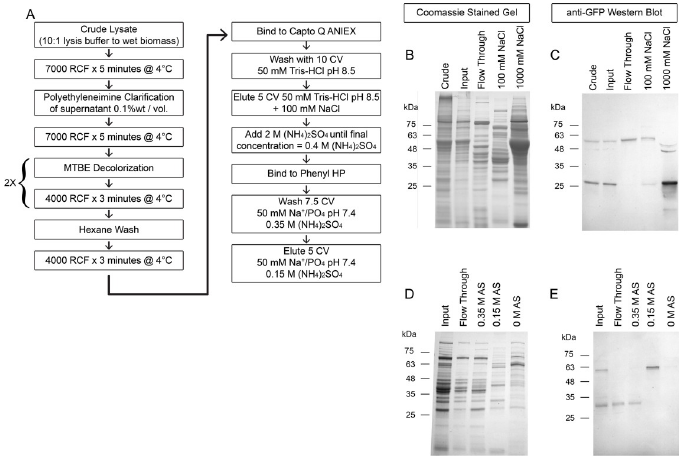
Fig 3. Summary of purification scheme for RBD::mClover retained in the ER-Golgi system. (A) Schematic summarizing our clarification and decolorization protocol prior to column chromatography purification of the RBD:: mClover domain through successive Anion Exchange and Hydrophobic interaction resin chemistries. (B) Coomassie stained gel of crude lysate total lysate, Polyethyleneimine/Organic solvent clarified input fraction followed by the Capto Q chromatography Flow through, 100 mM NaCl elution of the RBD::mClover, and 1 M NaCl stripping of the column. Crude and input represent 10 μ L of lysate while other fractions represent the same volume of a 20X concentration from the chromatography eluted fractions. (C) Western Blot characterization of the same samples as in panel B but using anti-GFP antibody to probe for the RBD::mClover complex. (D) Coomassie stained gel characterizing the Hydrophobic-interaction purification of the anion-exchange 100 mM NaCl fraction. All samples represent 10 μ L of a 20X concentration of each fraction. The input represents the 100 mM NaCl anion exchange fraction after the addition of Ammonium Sulfate (AS) to 0.4M. (E) Western Blot Characterization of the same samples using anti-GFP to detect the RBD::mClover gene product. The RBD::mClover can be separated from the lower molecular weight mClover degradation product.